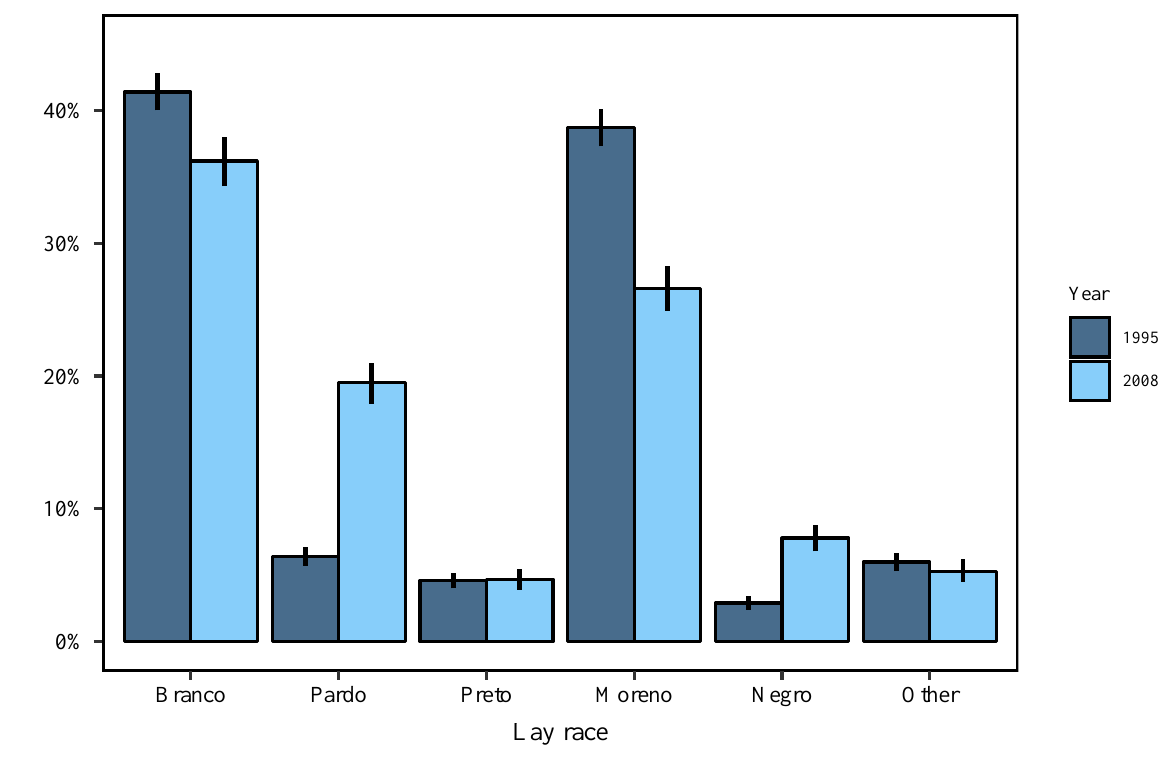
Figure 2: Racial composition by lay identification, 1995 and